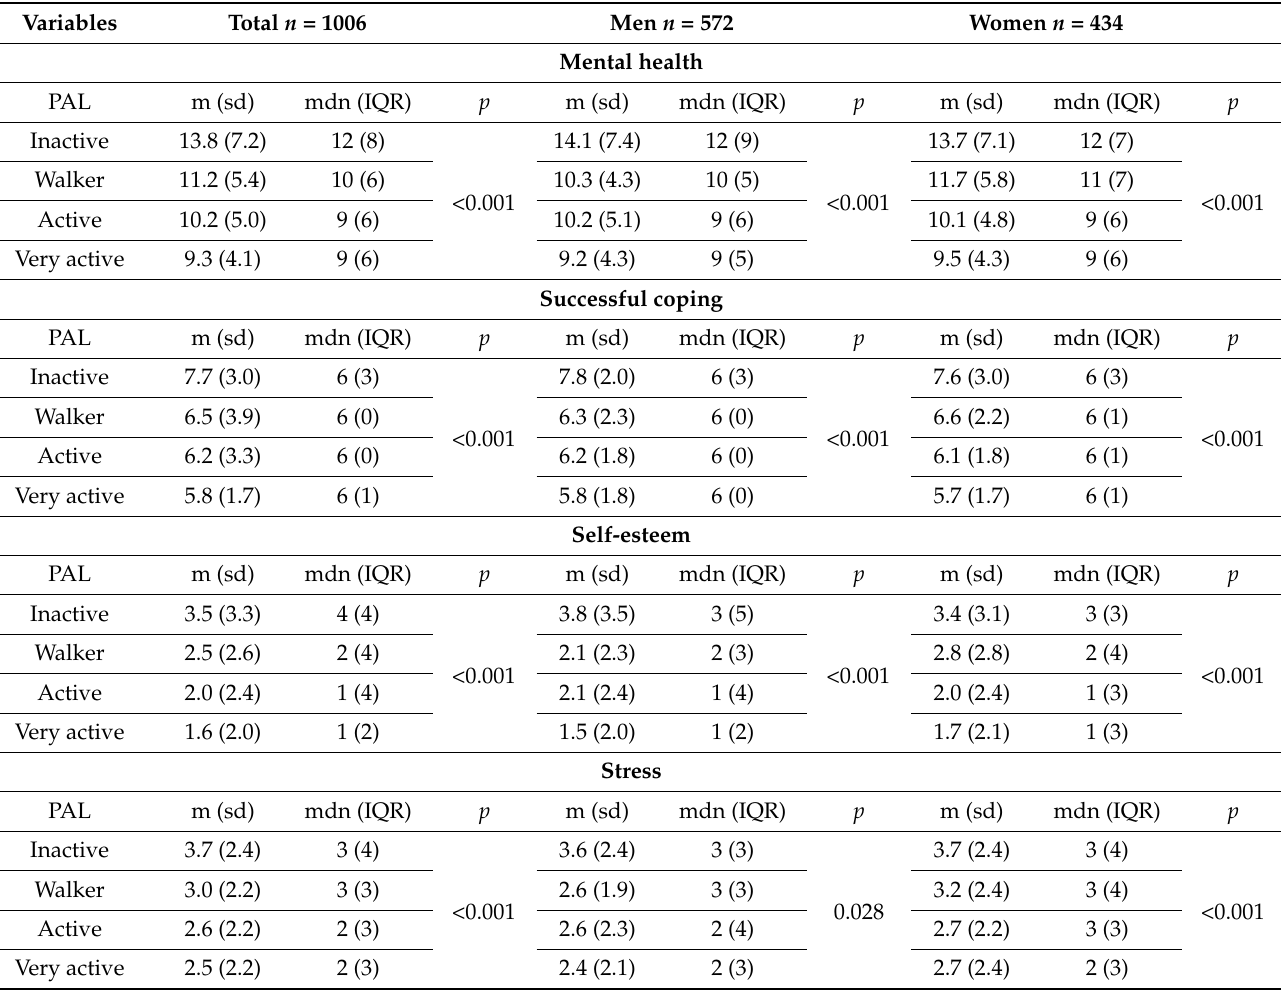
Table 2. Associations between the Physical Activity Level (PAL)and subscales from the mental health in Spanish adults with Asthma, according to the ENSE